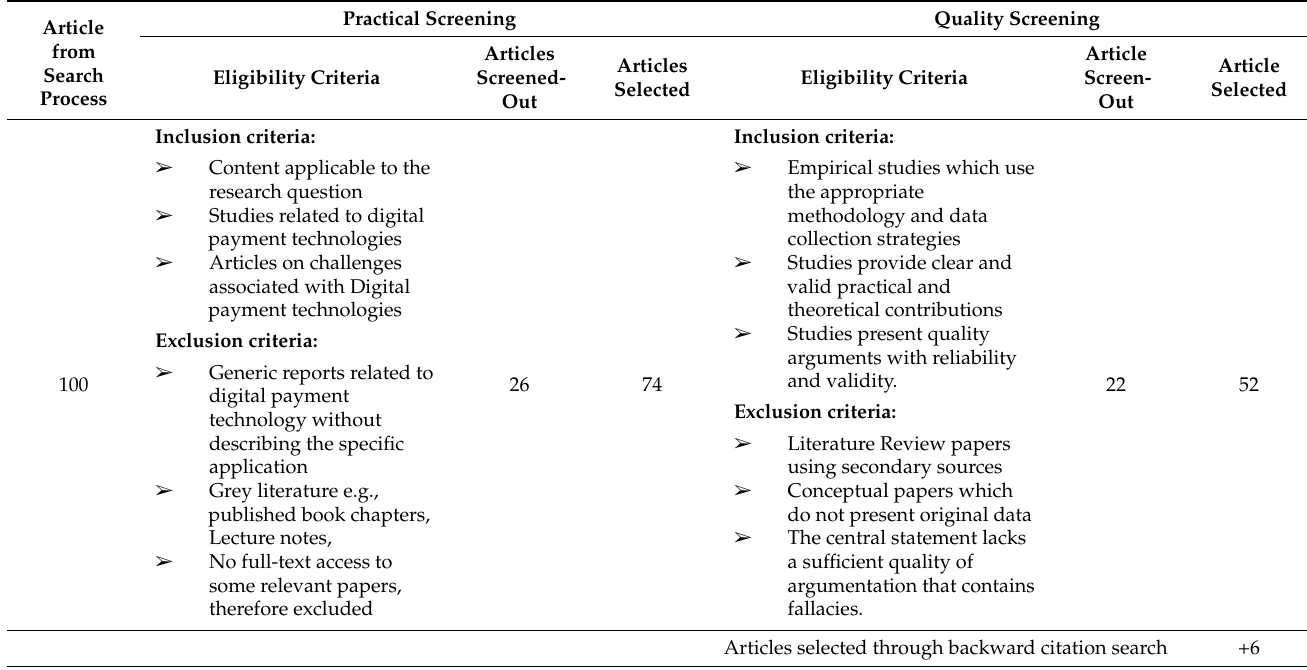
Table 4. Articles selected through (Step 4 and 5)—practical and quality